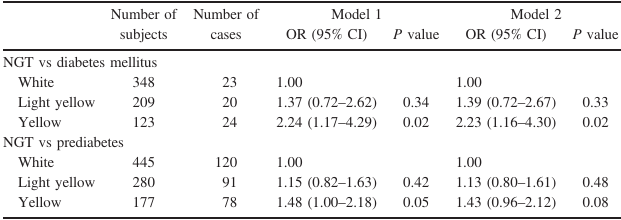
Table 2. Multivariable odds ratios (ORs) and 95% con fi dence intervals (CIs) for diabetes mellitus and